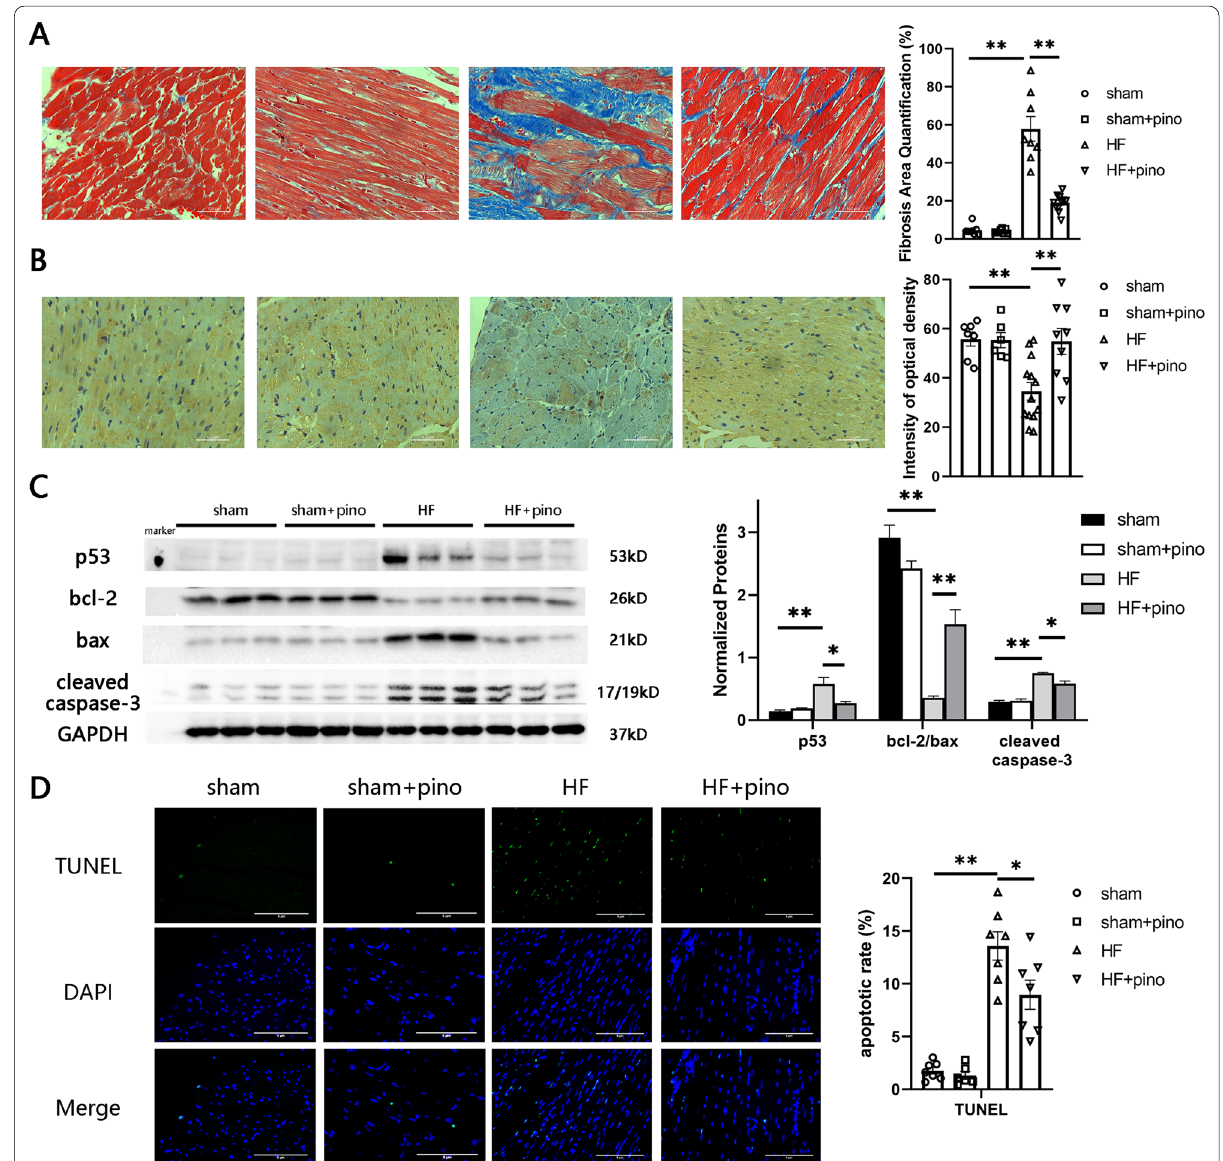
Fig. 3 Pinocembrin alleviated post-infarct heart failure-induced ventricular remodeling. A pinocembrin decreased collagen deposition in infarct border zone, evidenced by the Masson staining; B pinocembrin reversed the heart failure-induced rarefaction of vascular endothelial growth factor receptor 2, demonstrating an amelioration of angiogenesis; C western blot results showed that pinocembrin improved apoptosis. N quantified analysis of western blot. D Terminal-deoxynucleoitidyl Transferase-Mediated Nick-End Labeling (TUNEL) assay detected the apoptotic cardiomyocytes in infarct border zone or in the approximate region of apex cordis.*: p < 0.05; **: p <